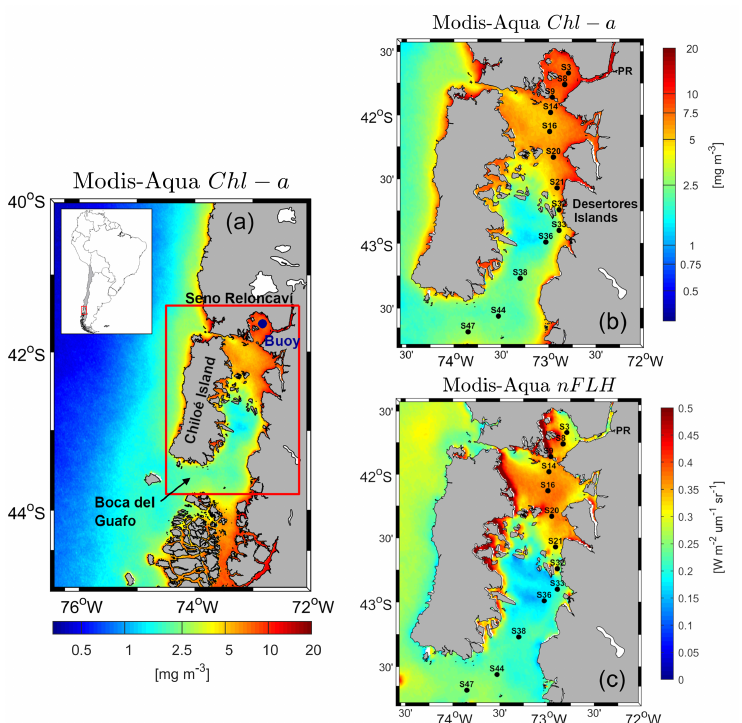
Figure 1. ( a ) Map of northern Patagonia. The Inner Sea of Chiloé (ISC) is enclosed in a red box and shown in ( b , c ). Black circles correspond to the location of oceanographic profiles shown in Figure 8. PR corresponds to the location of the Puelo River. The blue circle corresponds to the location of the oceanographic buoy in Seno Reloncavi. The average values of Moderate Resolution Imaging Spectroradiometer (MODIS) Chlorophyll-a (Chl-a) and Chlorophyll fluorescence (nFLH) (2003–2019) are color-coded in ( a – c ),